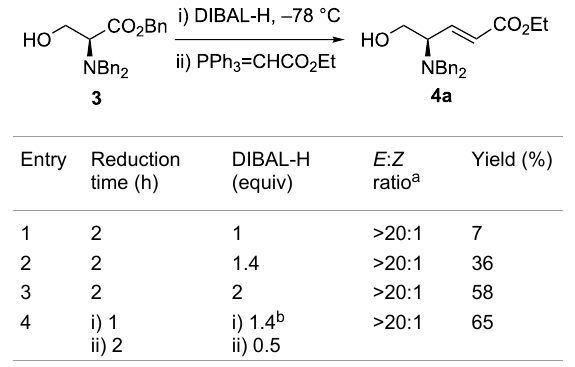
Entry Reduction time